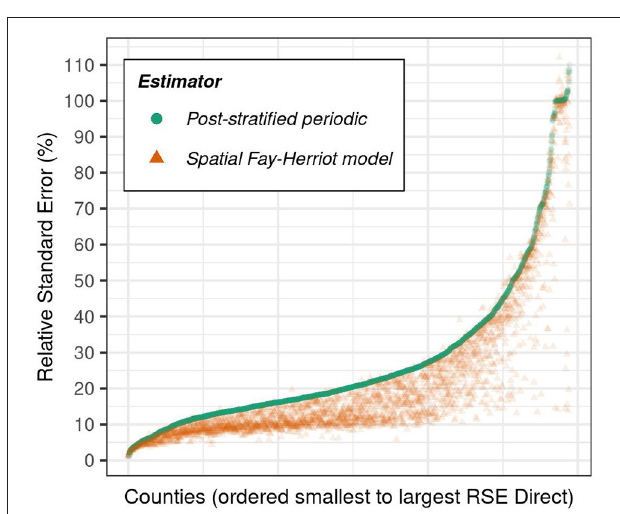
FIGURE 5 | Relative standard error (%) of model-based (i.e., spatial Fay-Herriot model) and post-stratified estimator estimators of mean forest carbon density by county, ordered by increasing relative standard error of the direct